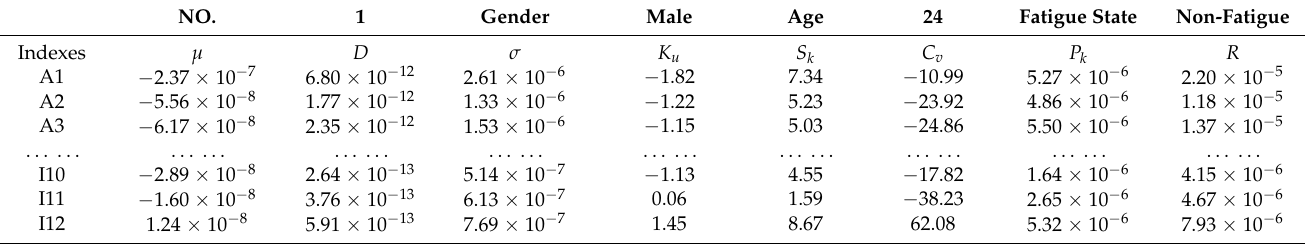
Table 6. Some experimental sample